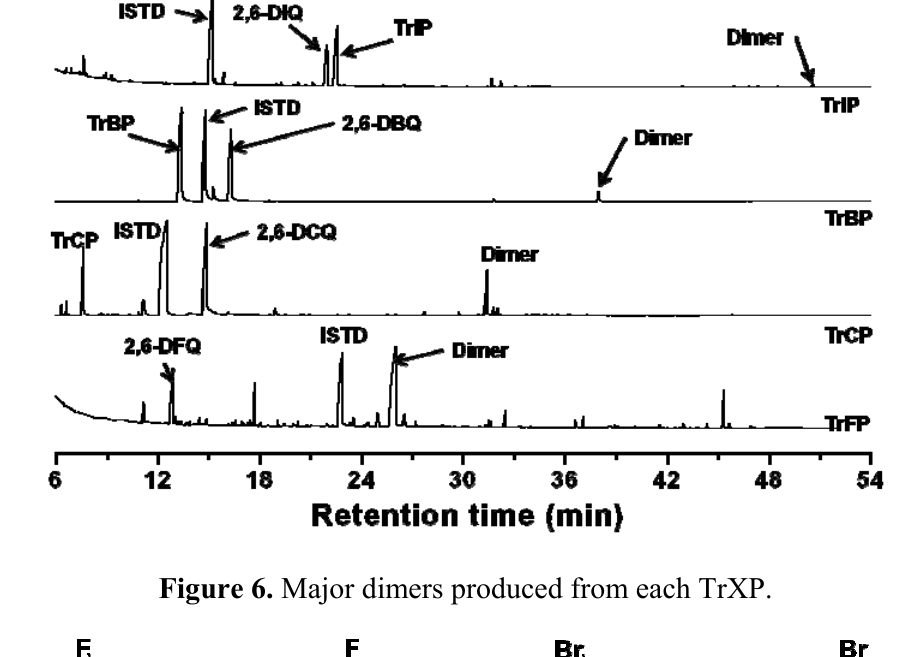
Figure 5. GC/MS chromatograms of hexane extracts of reaction mixtures using a